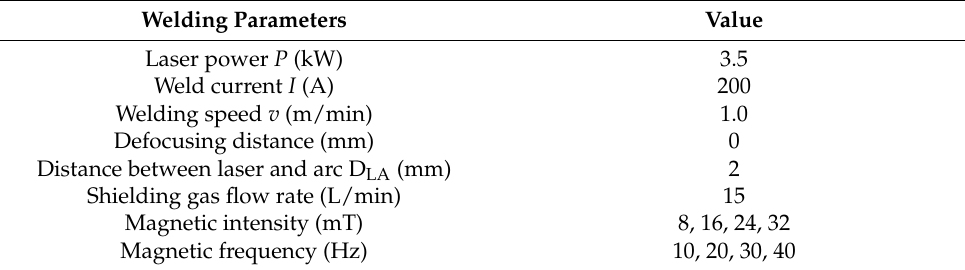
Table 2. Welding Table 2. Welding parameters.